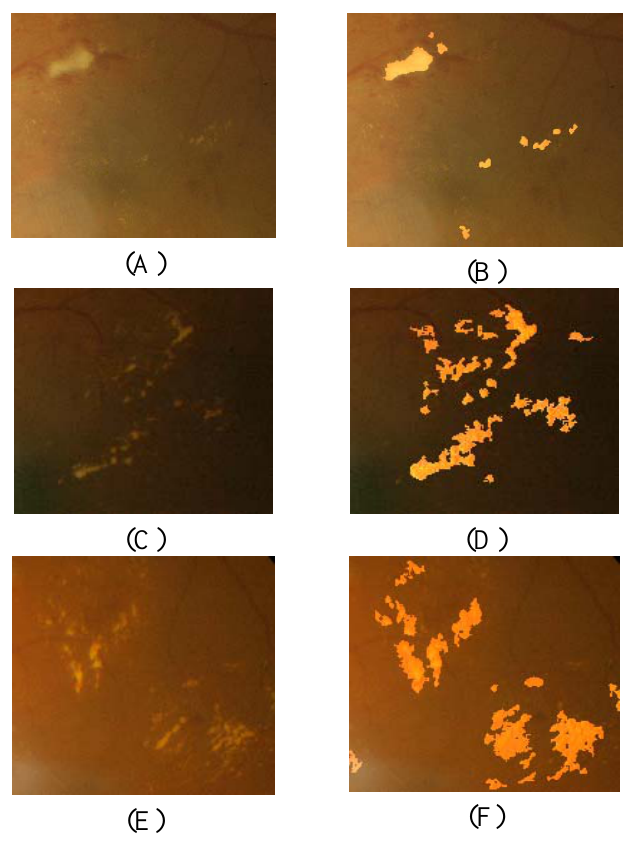
Figure 7. Exudates detection on low contrast images (A), (C) and (E) are original images, (B), (D) and (F) are detected exudates superimposed on original images of (A), (C) and (E)